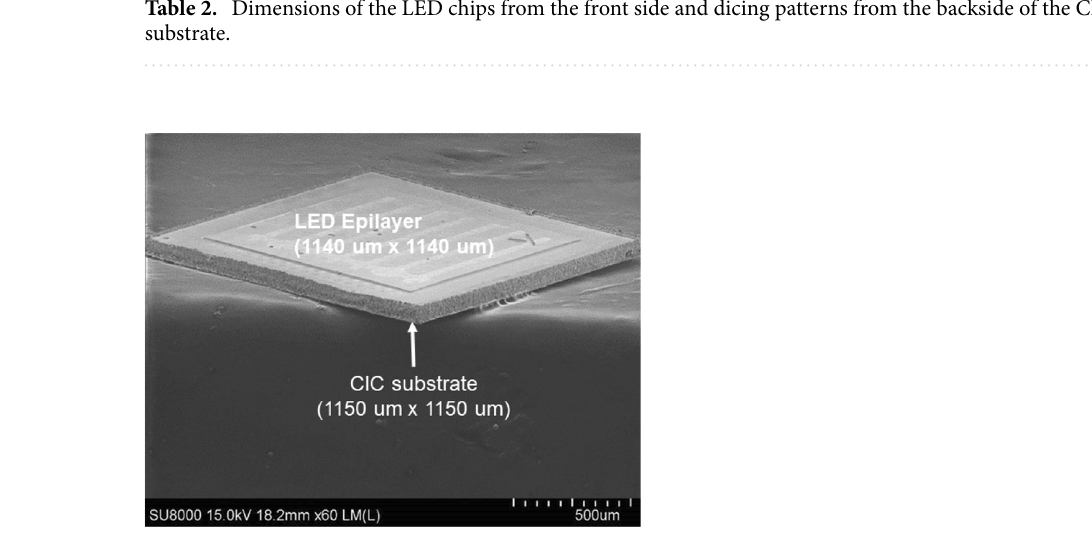
Figure 3. Typical single chip thin film AlGaInP LED on a CIC metal substrate.